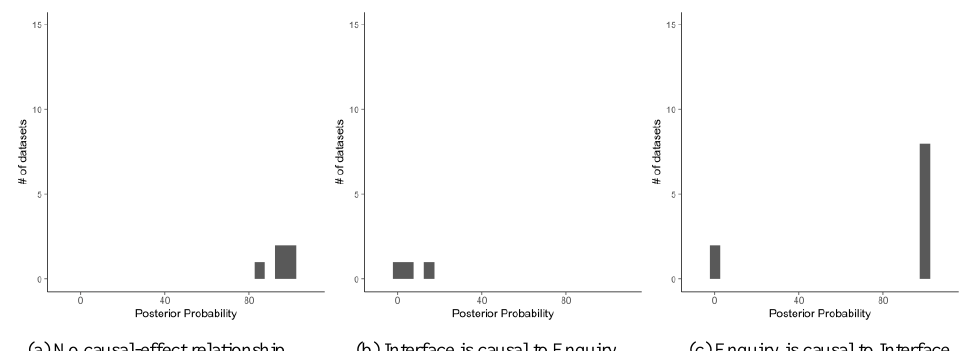
Fig. 7. Distributions of posterior probabilities between Interface and Enquiry in Finnish dataset when the number of bootstrap samples is